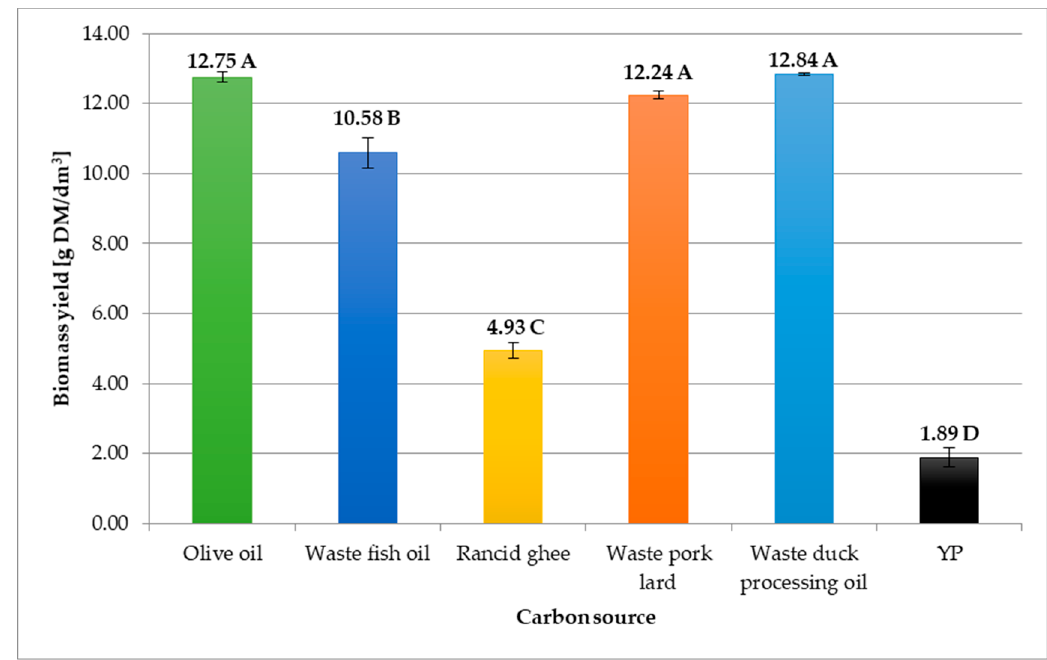
Figure 1. Effect of lipid-rich wastes on the biomass yield of C. cylindracea DSM 2031 after 65 h cultures. YP—control medium (10 g/L yeast extract (Y), 20 g/L peptone (P), pH = 5). Means with the same letter did not differ significantly ( α < 0.05).